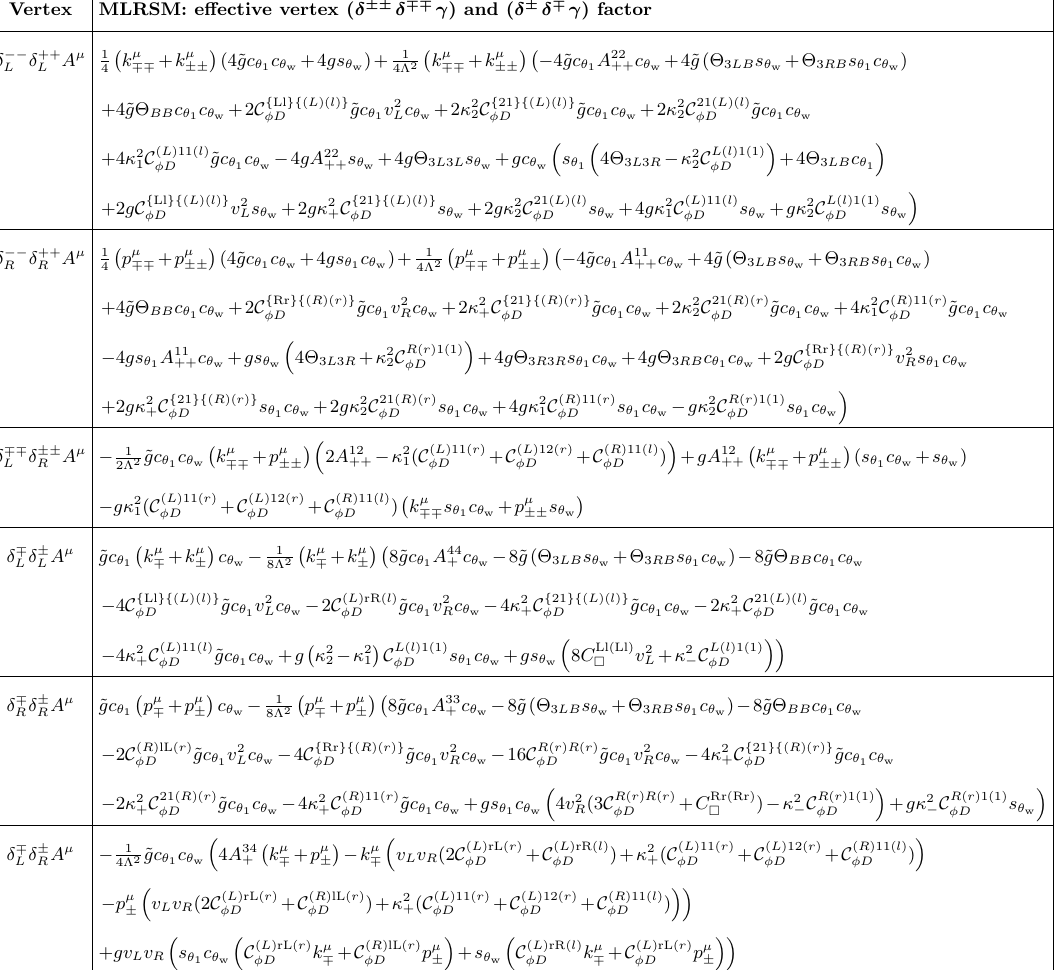
= sin (cid:18) i and c (cid:18) i , (cid:14) (cid:6)(cid:6) , (cid:14) (cid:6) and (cid:14) (cid:6) respectively. ~ (cid:18) 2 is the rede(cid:12)ned angle de(cid:12)ned in eq. (6.102) L R L R